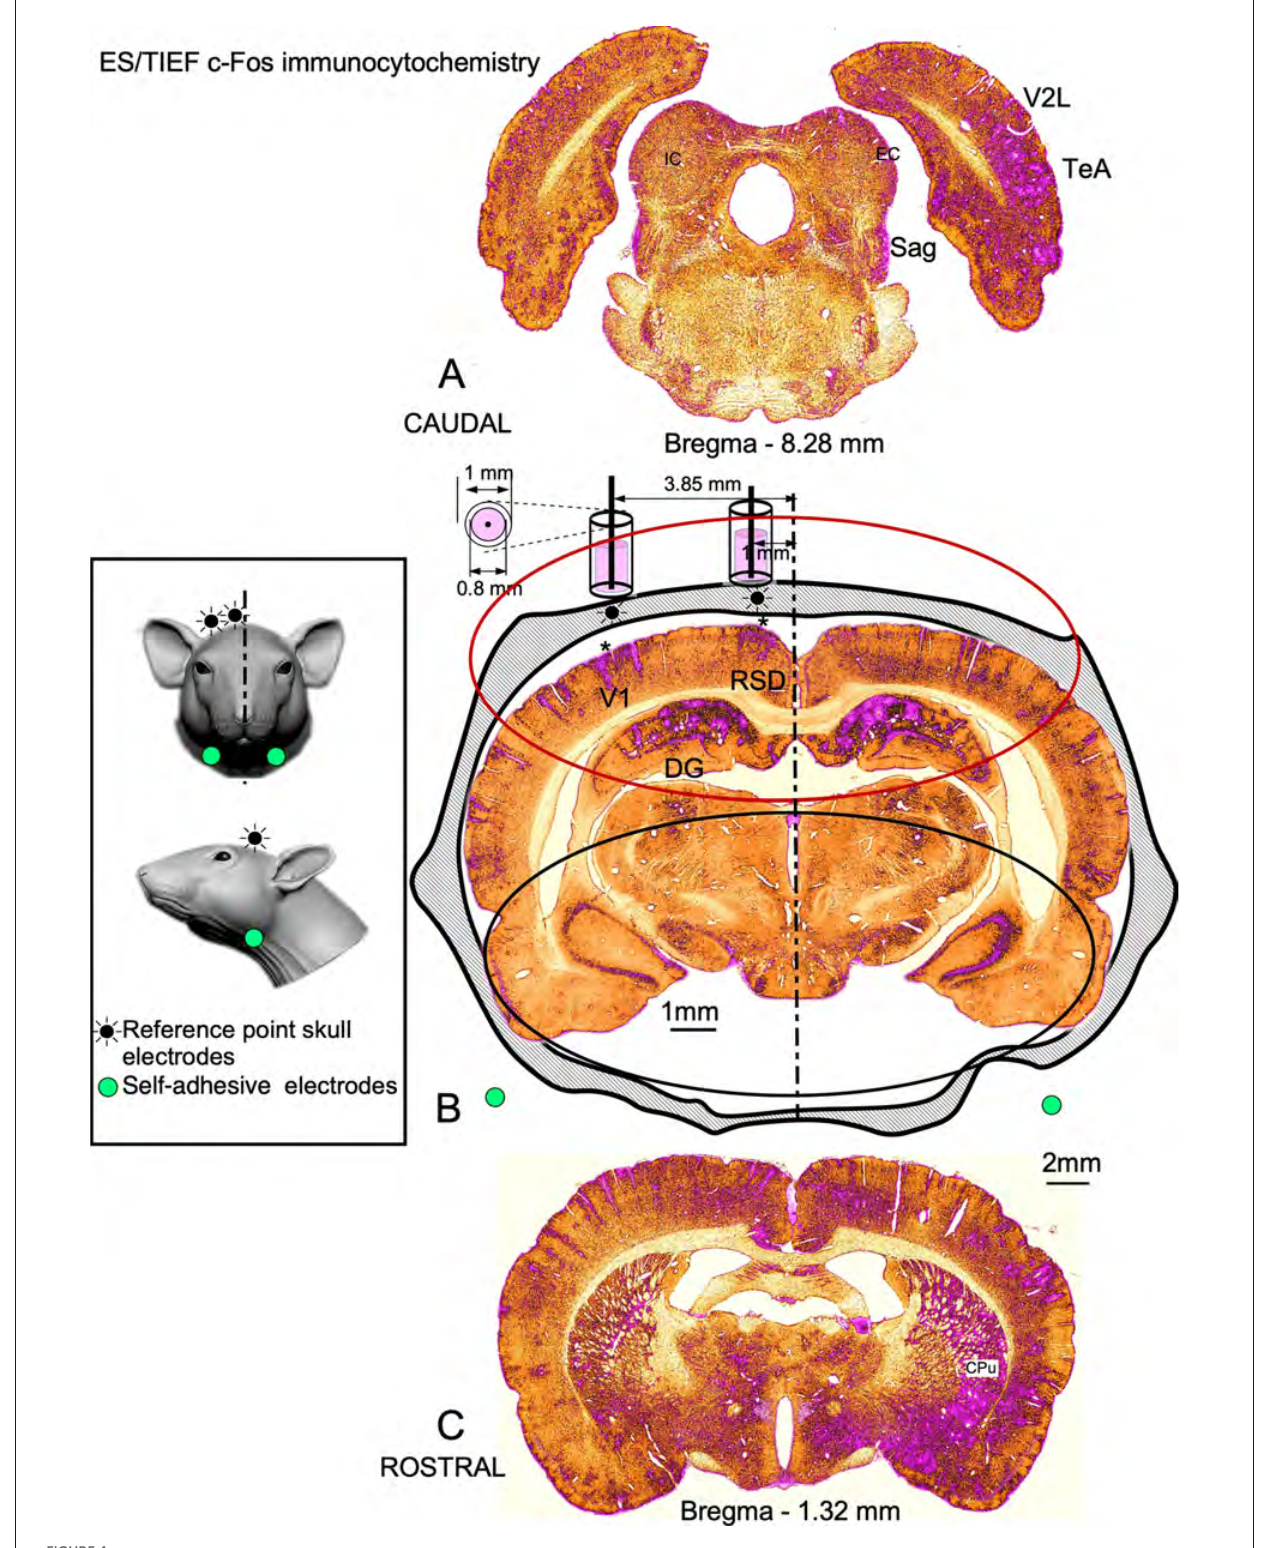
FIGURE4 Representative c-Fos immunostaining of ES/tTIS serial coronal sections after ICA pseudocolor conversion. (A) Top caudal, (B) electrode coordinates and (C) top rostral. Perivascular magenta reaction defining asymmetric (denser in the right hemisphere) areas of activation throughout the rostro- caudal axis. (A) At Bregma -8.28 mm, denser cell and perivascular immunoreactivity is observed in the right temporal associative (TeA), secondary visual cortex (V2L), external cortex of the inferior colliculus (EC), and nucleus sagulum (Sag). IC, Inferior colliculus. (B) In the electrodes, coordinates at Bregma - 4.56 mm, at the level of the retrosplenial cortex (RSD) and visual primary cortex (V1), higher density areas (asterisks) are observed in the